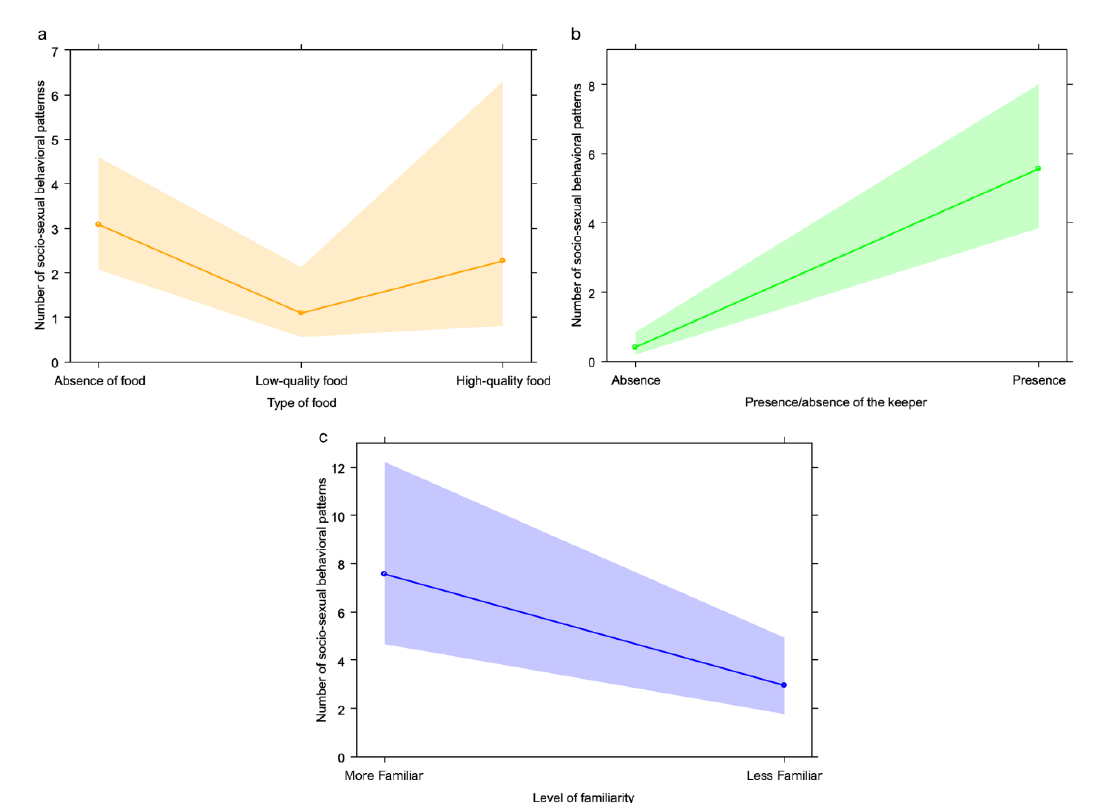
Figure 3. Effect plot of the variables with a significant effect on sociosexual behavior. The number of sociosexual behavioral patterns (y-axis) was ( a ) highest in absence of food (x-axis), ( b ) highest in presence of the keeper and especially ( c ) with more familiar keepers.